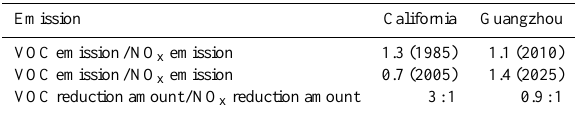
Table 3. Comparison of VOCs and NO x emission control in Cali- fornia and